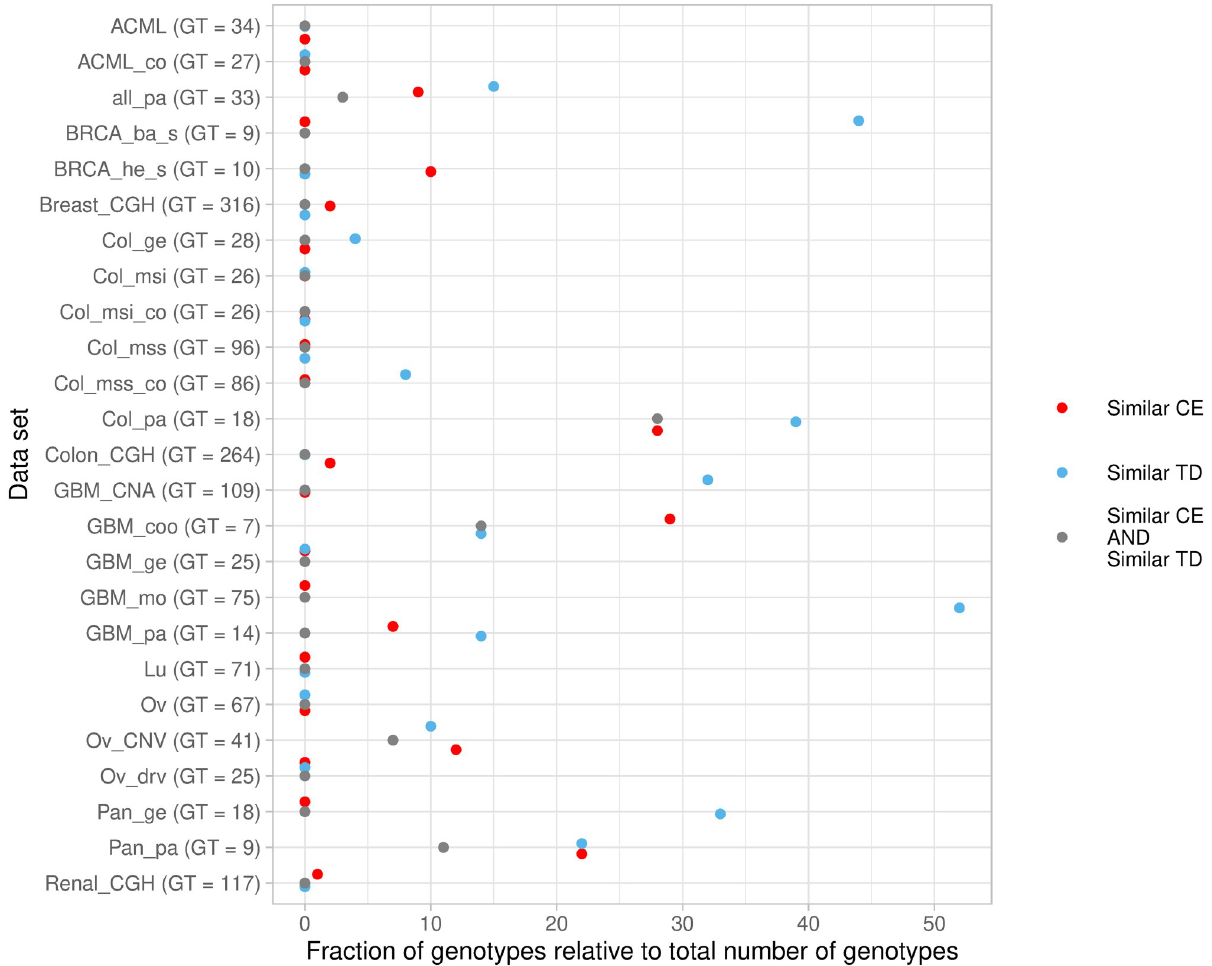
Fig 4. Percentage of genotypes with similar TD and similar CE predictions for the 25 biological data sets. For each data set, the red points show the percentage of genotypes in which predictions had both similar CE ( JS � 0.0677) and different CE-TD ((1/2) ( JS + JS ) � CBN , MHN CBN , CBN _ td MHN , MHN _ td 0.7), the blue dots those with similar TD ( JS � 0.0677) and different CE-TD, and the gray points the percentage of genotypes that had CBN _ td , MHN _ td similar CE, similar TD, and different CE-TD. Values shown are the percentage relative to the total number of genotypes for which we computed predictions, which are the genotypes observed in the samples, except for the genotype with all genes mutated, if it was observed. In parentheses, after the data set, we indicate the total number of genotypes observed (GT).